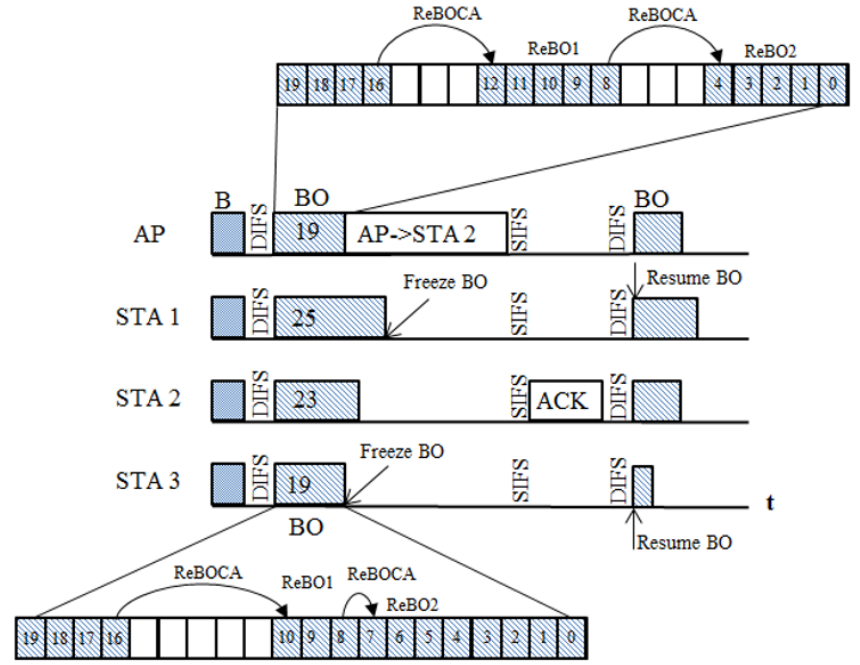
Figure 1. IEEE 802.11 DCF transmission procedure in CSMA/RCA with